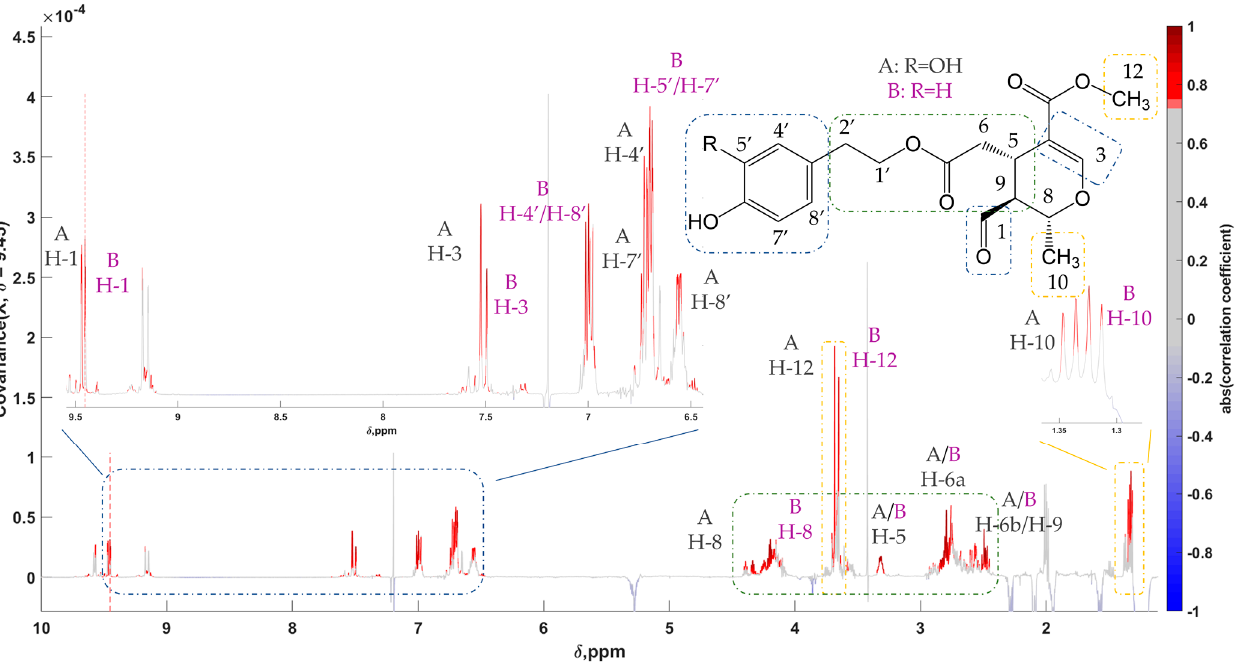
Figure 6. STOCSY 1D pseudo-NMR spectrum of MFOA-5S,8R,9S isomer ( A ) and MFLA-5S,8R,9S isomer ( B ). Correlation coefficients to the other signals in the median EVOO NMR spectrum are color-encoded: the “driver peak” was at 9.450 ppm. Zoom-in of the aldehydic and aromatic regions is also presented.